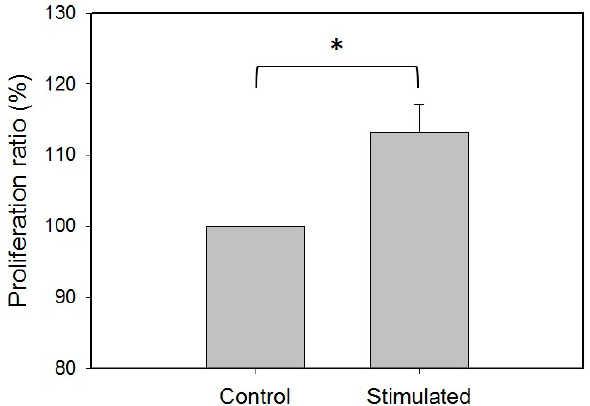
Figure 7. Investigation of the cell proliferation after the stimulation of the multi-axial tensile strain for three days. The control group represents the cells that were cultured without tensile strain. The stimulated group represents the cells were cultured with tensile strain. The ADSCs were isolated from the tissue samples of patients #1 and #2. The data were generated from three repeated experiments for each tissue sample. The data are presented as mean ± standard error. The results were analyzed using one-way analysis of variance (ANOVA). Statistical significance is indicated as * for p < 0.05.